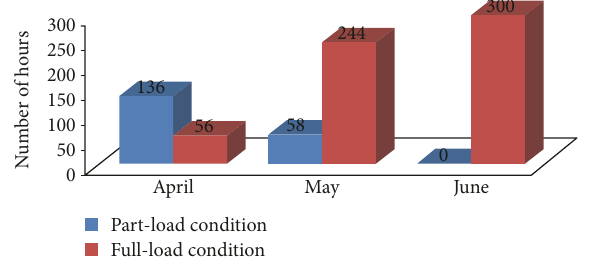
Figure 7: Working hours of the solar fi eld in April, May, and